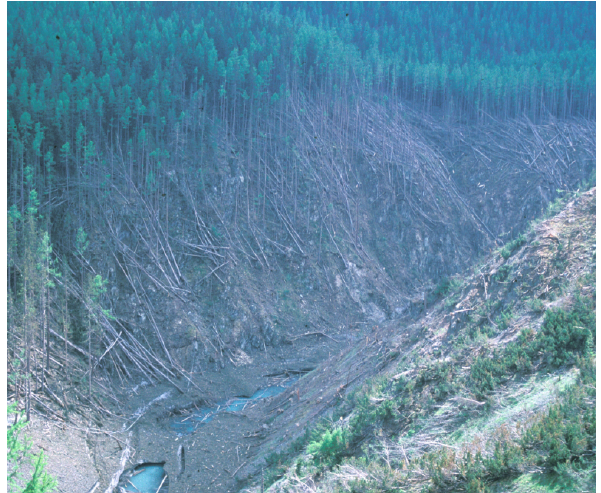
Figure 1. Tree breakage caused by the air blast of a powder avalanche, Zernez, Switzerland, 1999. The trees failed through a combination of bending and root-plate overturning. Photograph: Pe- ter Bebi,